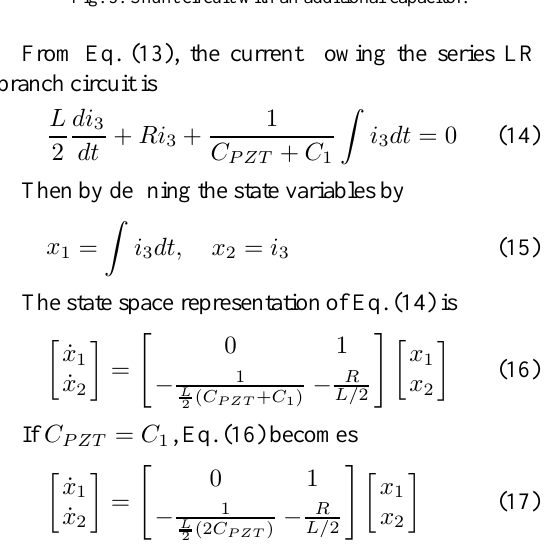
Fig. 3. Shunt circuit with an additional